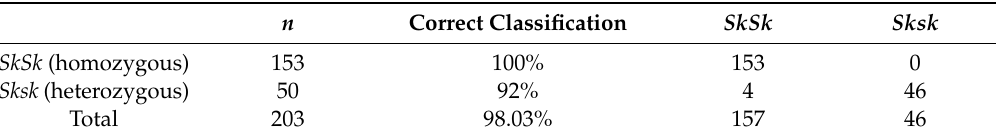
Table 4. Classification results of the classification model (PLS-DA) developed to discriminate between homo- and heterozygous sweet almond categories ( n = 203, 6 variables, scaling to unit variance; 3 latent variables), cross-validated by leave 10%-out. n Correct Classification SkSk Sksk